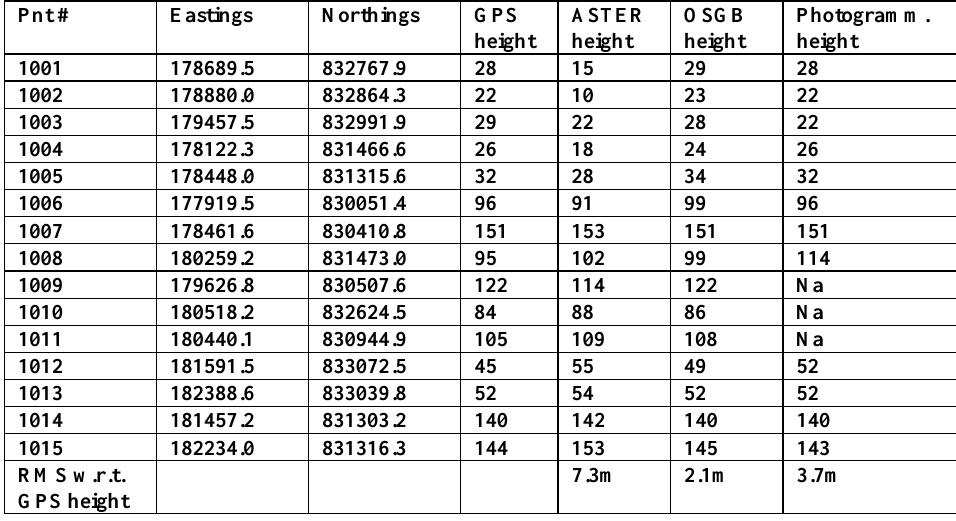
TABLE 1. Check point accuracies derived from precise GPS points 1001:1015 and their corresponding ASTER GDEMv2, OSGB and photogrammetrically derived heights (all heights with respect to the ODN vertical datum). Pnt